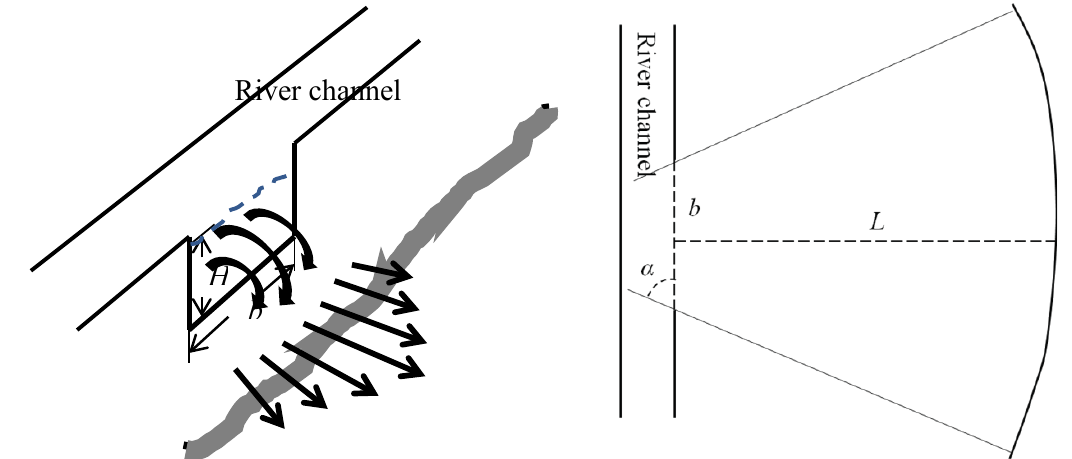
Fig. 5 Diagram of controlled overbank flows via a lowered levee and the geometry of the hypothetical sectorial flooding